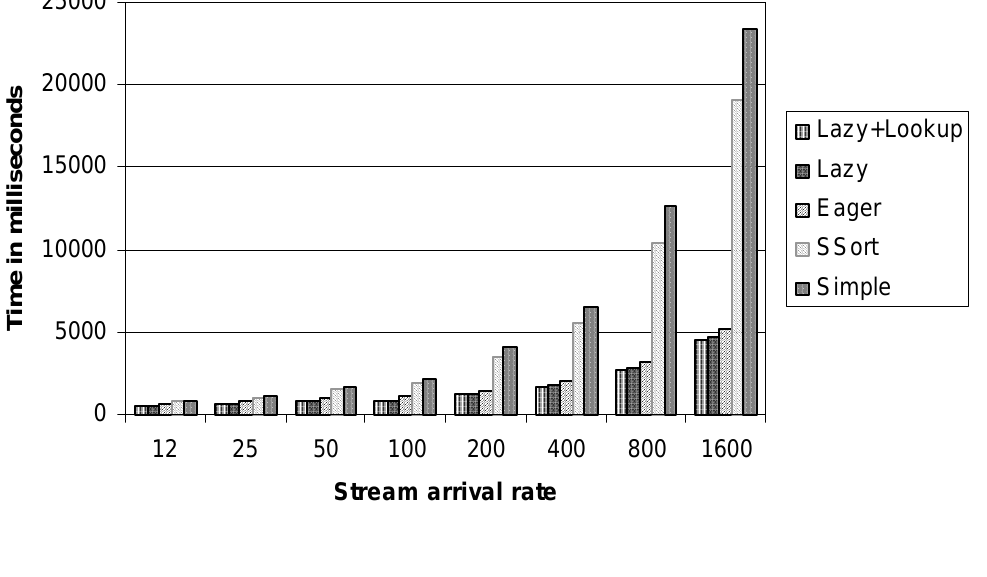
Figure 4. The average response times under various arrival